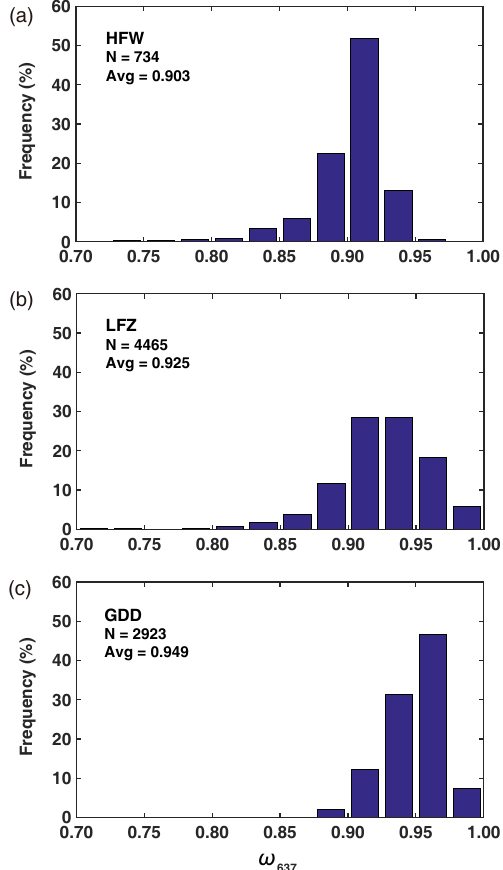
Figure 6. Same as Fig. 5 but for aerosol size distribution (d N / dlog D p , 0.5µm< D p <5µm) in (a) Wuwei, (b) Zhangye, and (c) Dunhuang from 3 April to 16 May 2014. Note that data collected during the strong dust storm in Zhangye are excluded.